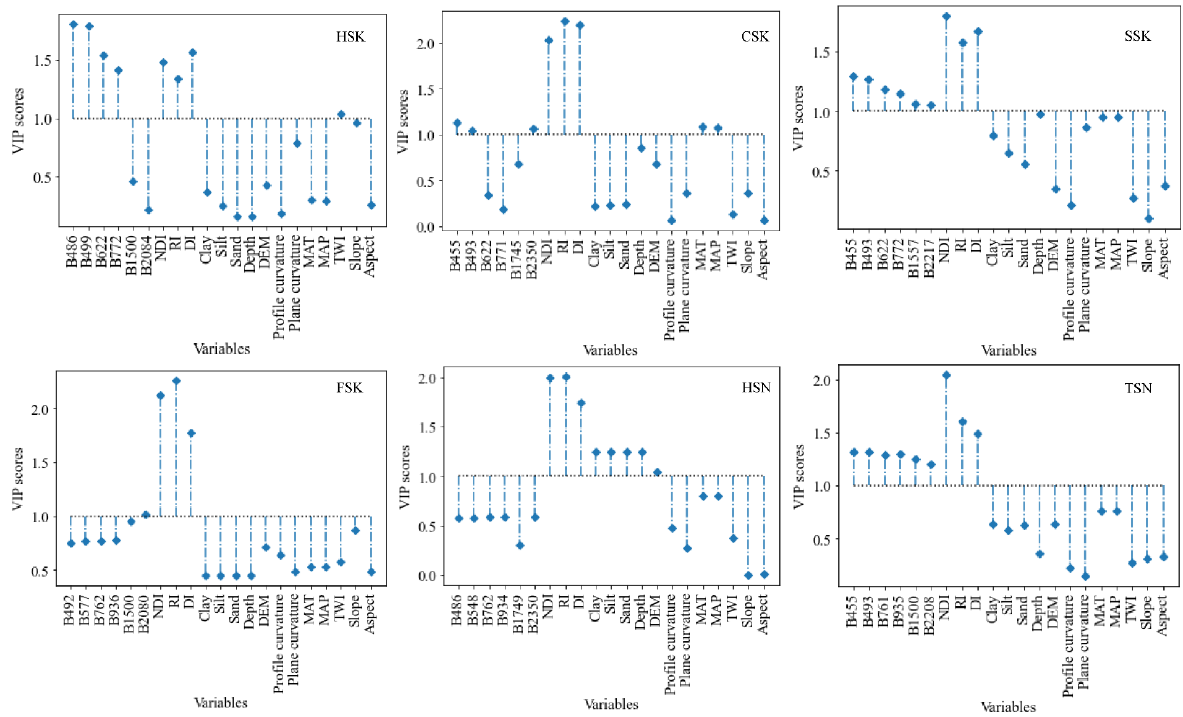
Figure 7. Variable importance projection (VIP) analysis between soil EC and variables.